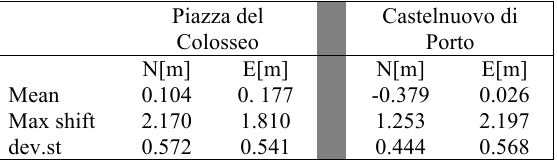
Table 3. Shift analysis - 40 points - parameters: scientific software